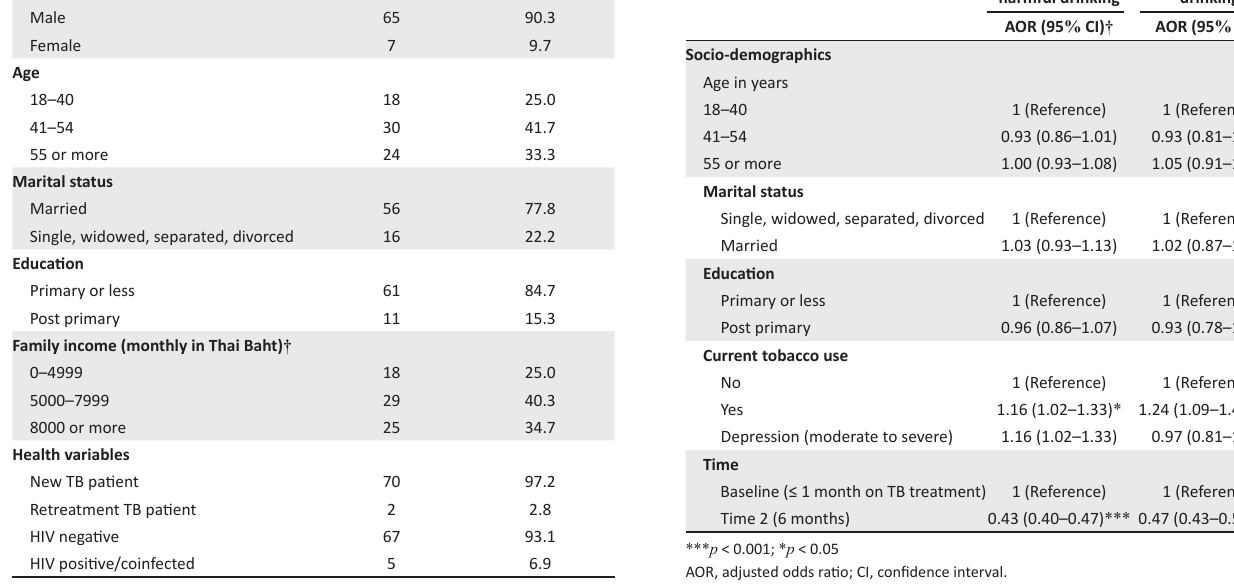
TABLE 3: Predictors of hazardous or harmful drinking and binge drinking. Variables